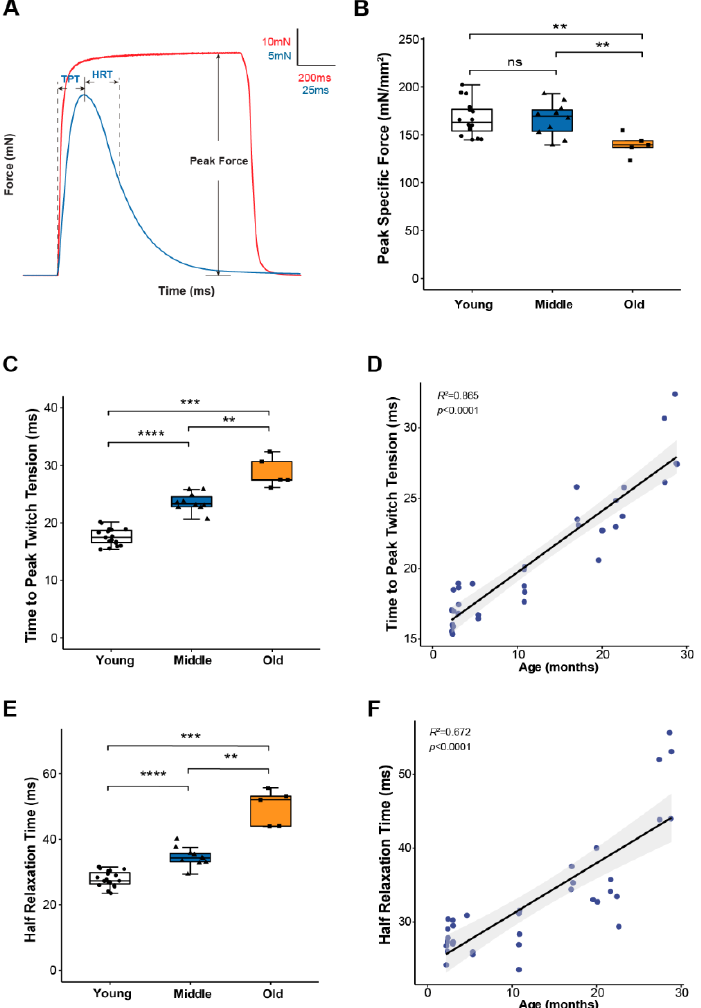
Figure 1. Lumbrical muscle contractile properties. ( A ) Representative traces of force generation during twitch (blue) and tetanic (red) contractions, with parameters used to describe muscle contractile properties annotated on the graph. Data shown for ( B ) peak specific force, ( C ) time to peak twitch tension (TPT), and ( E ) half relaxation time (HRT) for lumbrical muscles from young (n = 18, white, cricle), middle (n = 10, blue, triangle) and old (n = 5, orange, square) aged wild type mice. Specific force was calculated by normalizing the maximum isometric tetanic force by maximum muscle cross-sectional area. Additionally, shown are correlations between ( D ) age and TPT and ( F ) age and HRT analyzed by Pearson correlation (TPT: R 2 = 0.865, p < 0.0001; HRT: R 2 = 0.672, p < 0.0001). Data in B , C , and E are presented as individual data points with box plots and error bars indicating the minimum, first quartile, median, third quartile, and maximum number of the dataset. Data were analyzed by one-way ANOVA, ** p < 0.01, *** p < 0.001, **** p <